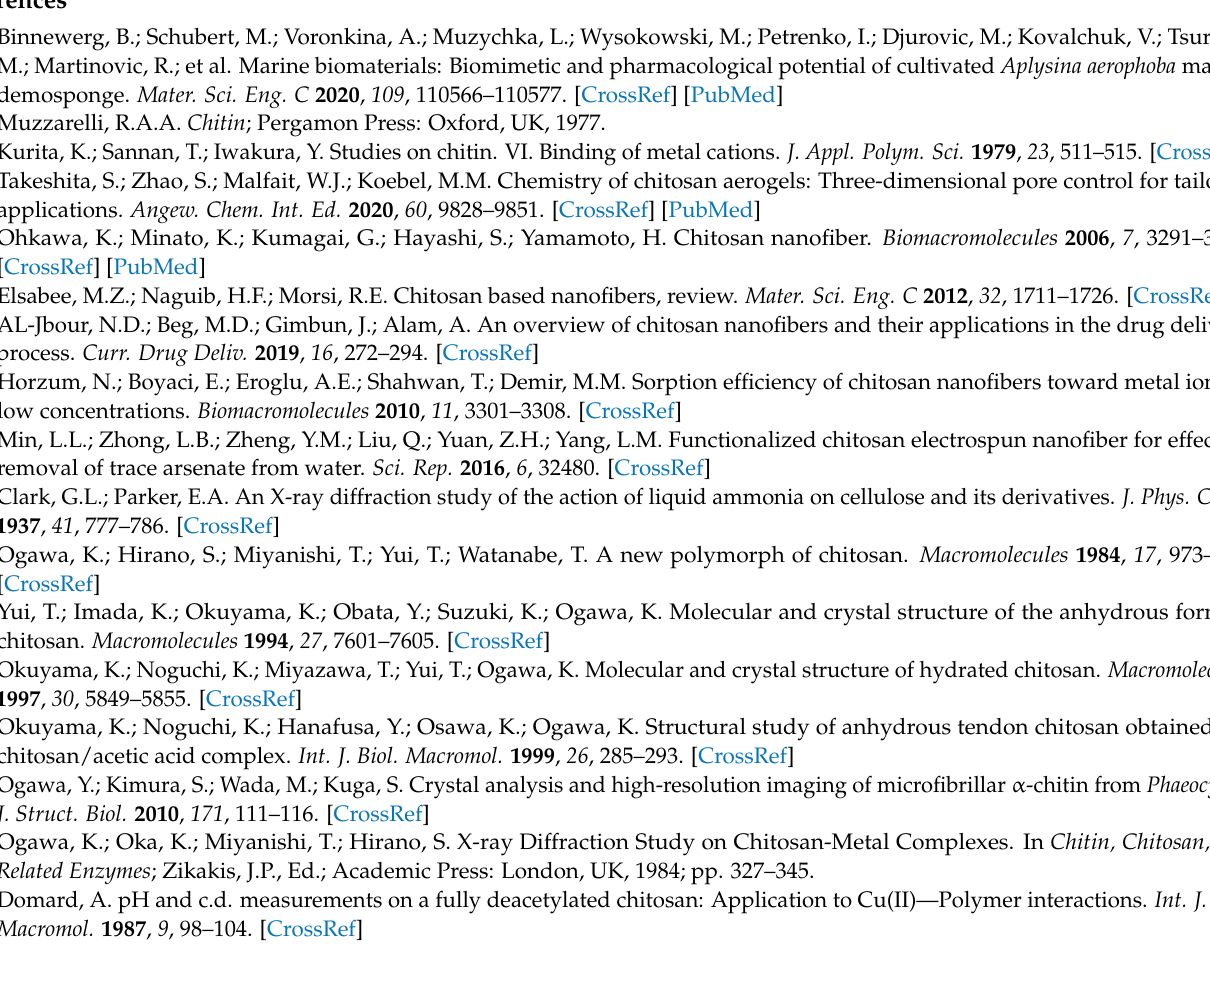
search; Table S3: Fractional atomic coordinates of the final crystal structure; Table S4: Observed and calculated structure factor amplitudes of the final